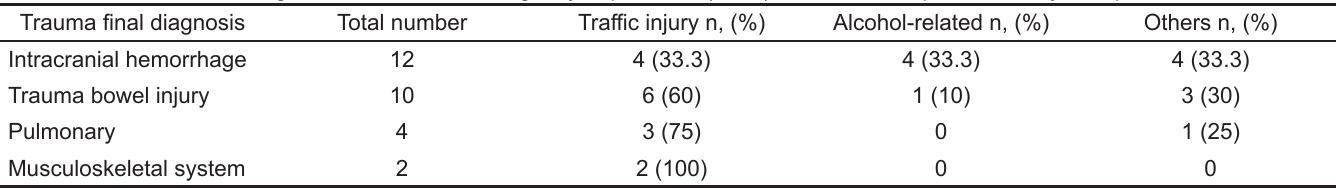
Table 2. Trauma-related diagnostic error in the emergency department (n=28): a medical malpractice study in Japan 1961-2017.*